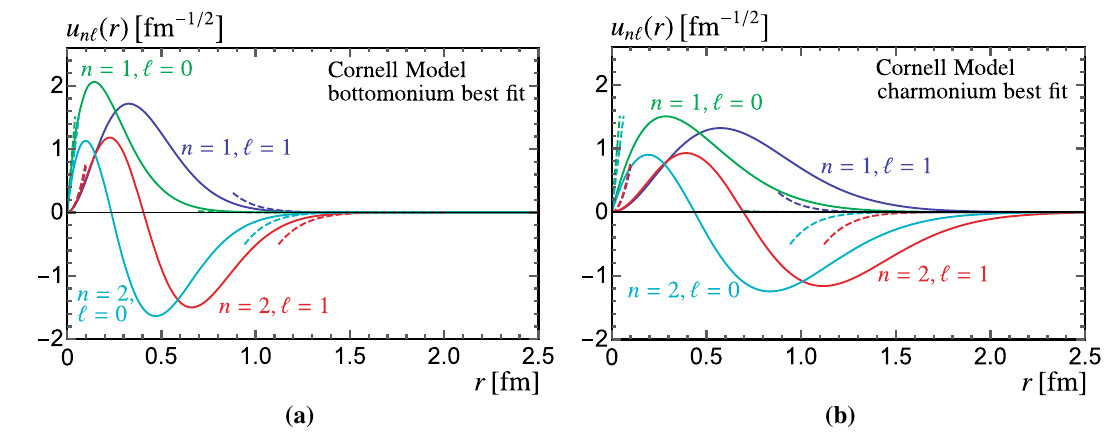
Fig. 3 Eigenfunctions of the static Cornell potential, shown as the reduced wave functions u n (cid:6) ( r ) , obtained using the central values of our fit to bottomonium ( a ) and charmonium ( b ) experimental data. Green